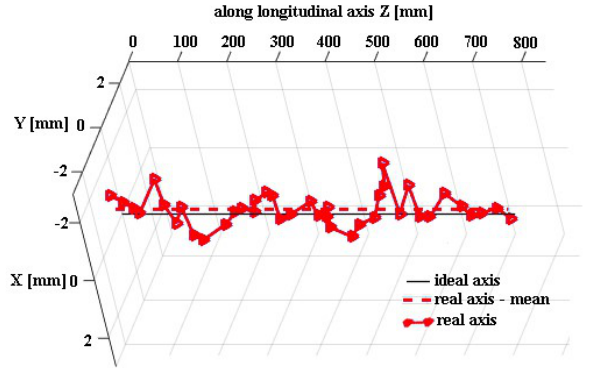
Figure 12 . Study of straightness of longitudinal axis of the tubular elements (modified by Laghi et al.,